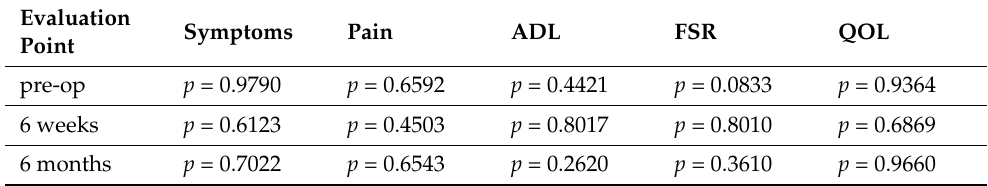
Table 2. Comparison of KOOS scores between both groups at 6 weeks and 6 months; p values